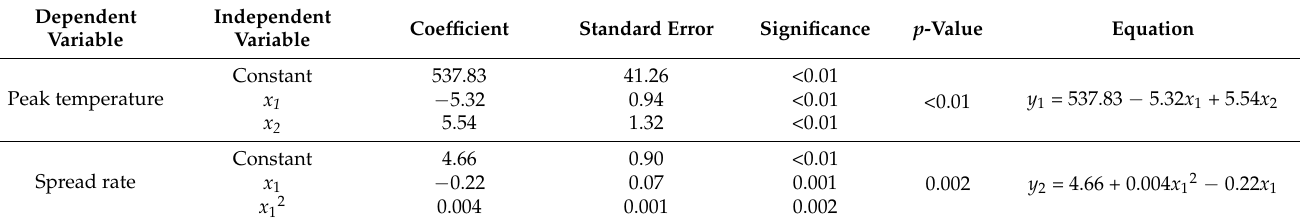
Table 2. Regression fitting of top temperature and spreading rate during the sub-surface fire.